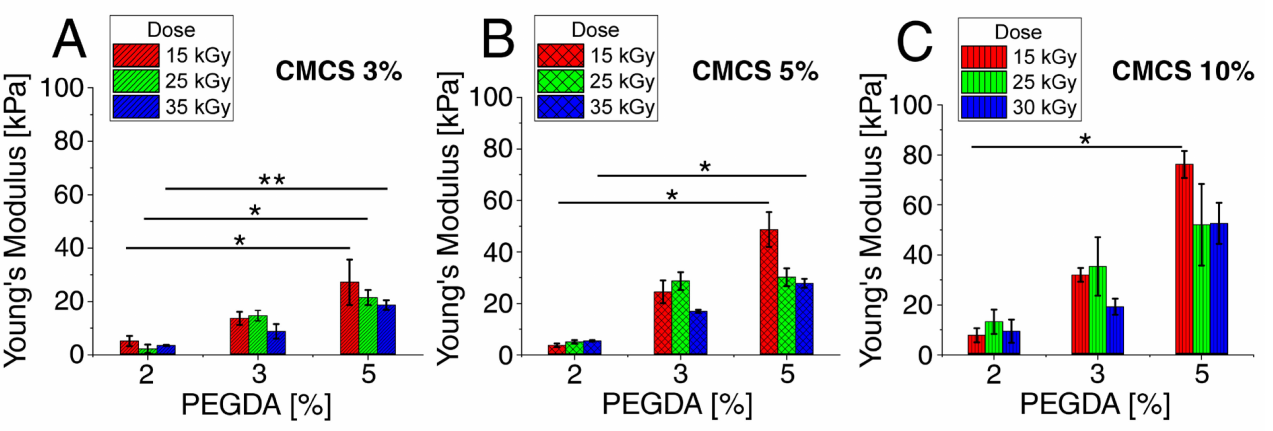
Figure 3. Young’s Modulus (kPa) for hydrogels with various PEGDA and radiation doses for ( A ) CMCS 3%, ( B ) CMCS 5%, and ( C ) CMCS 10%. The p -values of the post hoc test are provided; p < 0.05 (*), p < 0.01 (**). Measurements were made at room temperature (~25 ◦